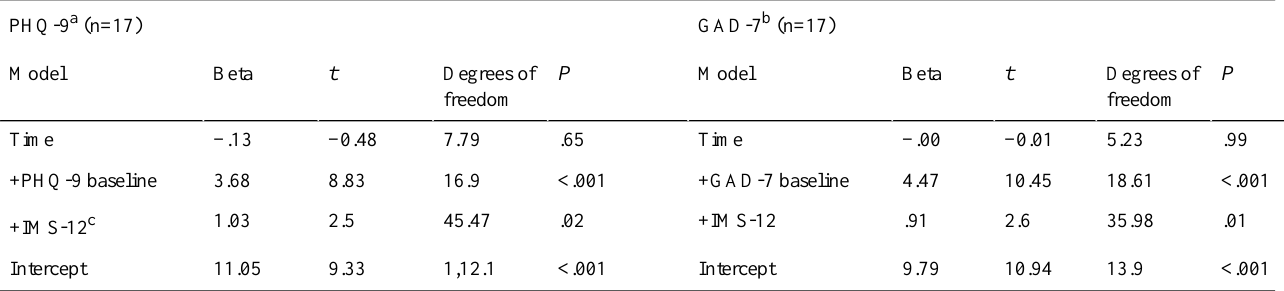
Table 3. Model variables for the prediction of PHQ-9 and GAD-7 from time, baseline measurements, and